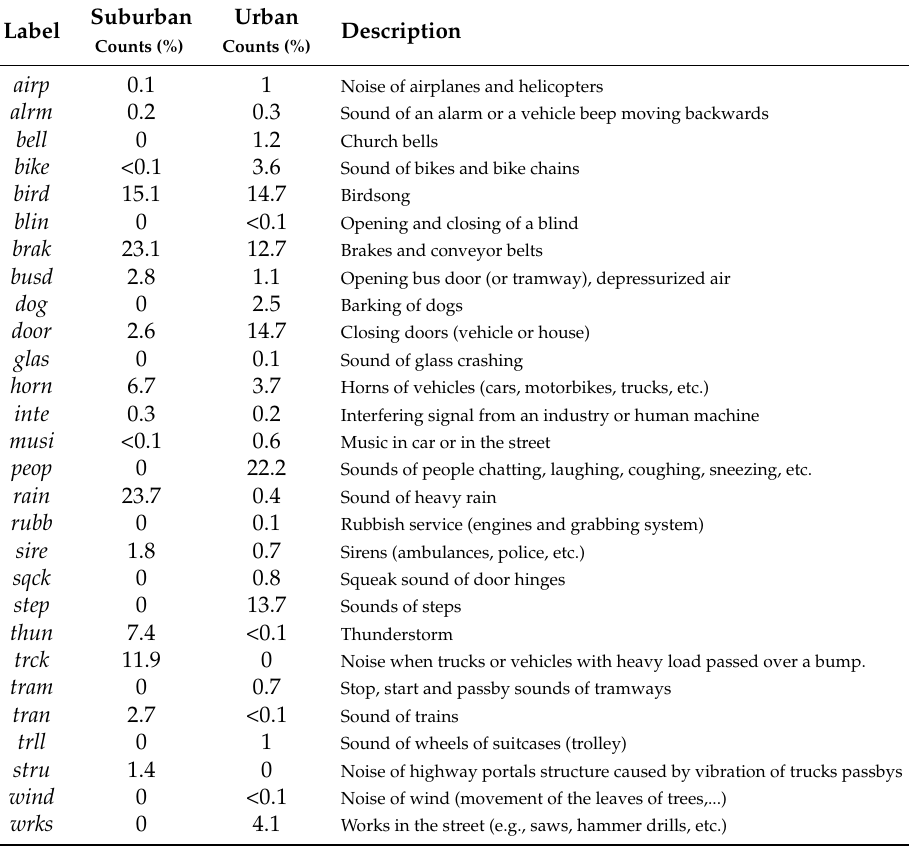
Table 1. Description and % of occurrences of the 28 sound subcategories attributed to anomalous noise events found throughout the manual labeling process of the WASN-based urban and suburban acoustic databases.